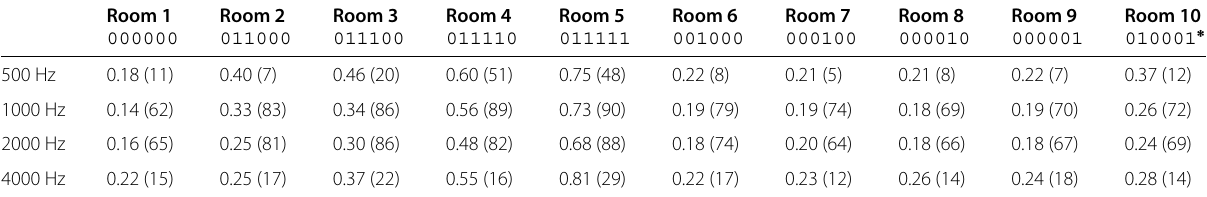
Table 5 Reverberation time per octave bands RT 60 ( b ) calculated in the 10 room